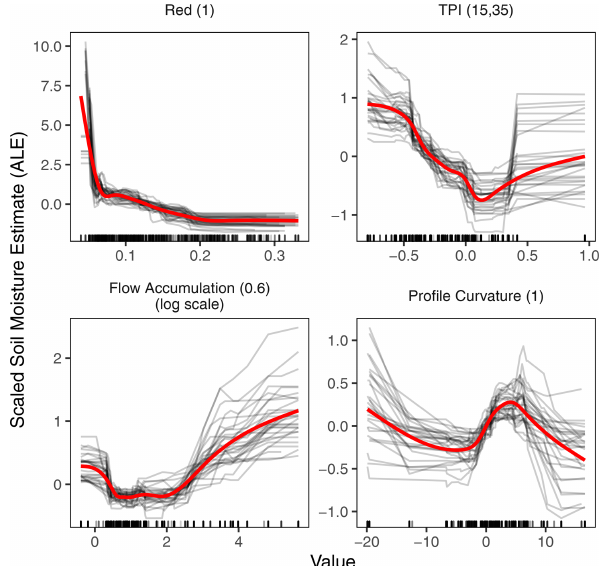
Figure 9. ALE plots for four selected high-importance predictor variables. The black curves represent the individual effects of the 30 models, and red curves are smoothed trend lines over all individ- ual models. Marks along the x axis show the distribution of the data in the model training